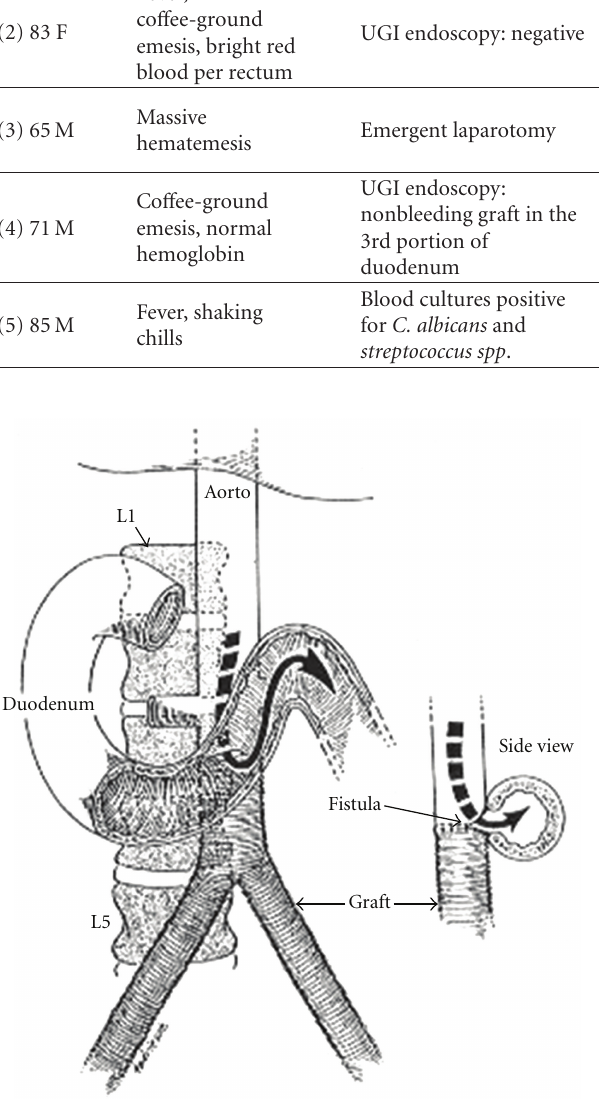
Figure 1: Drawing of aortoenteric fistula at the anastomosis of the abdominal aortic graft. Reproduced with permission from New England Journal of Medicine [13].